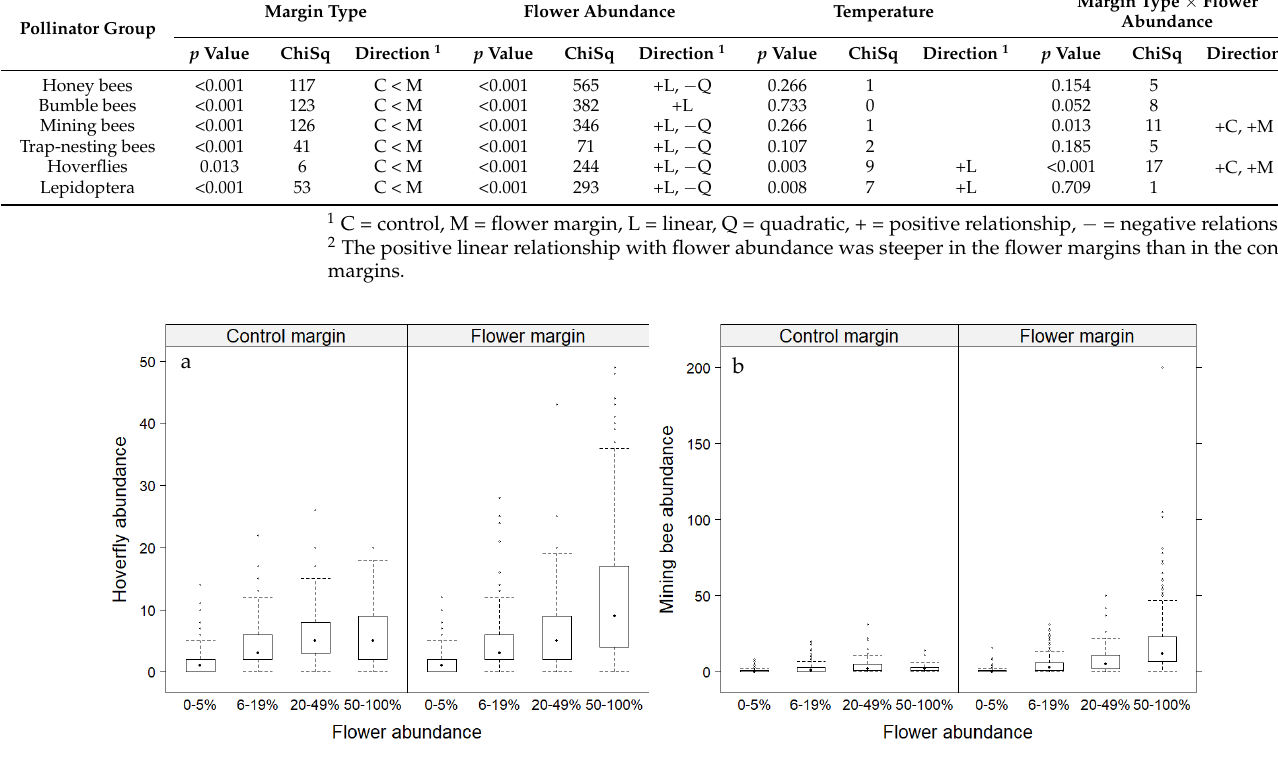
Figure 2. The relationship between pollinator and flower abundance in the control margins and margins planted with a pollinator friendly seed mix, for hoverflies ( a ) and mining bees ( b ). The boxes are the 25th and 75th percentile with the black dot showing the median. The whiskers are 1.5 times the interquartile range and the hollow dots are points falling outside that